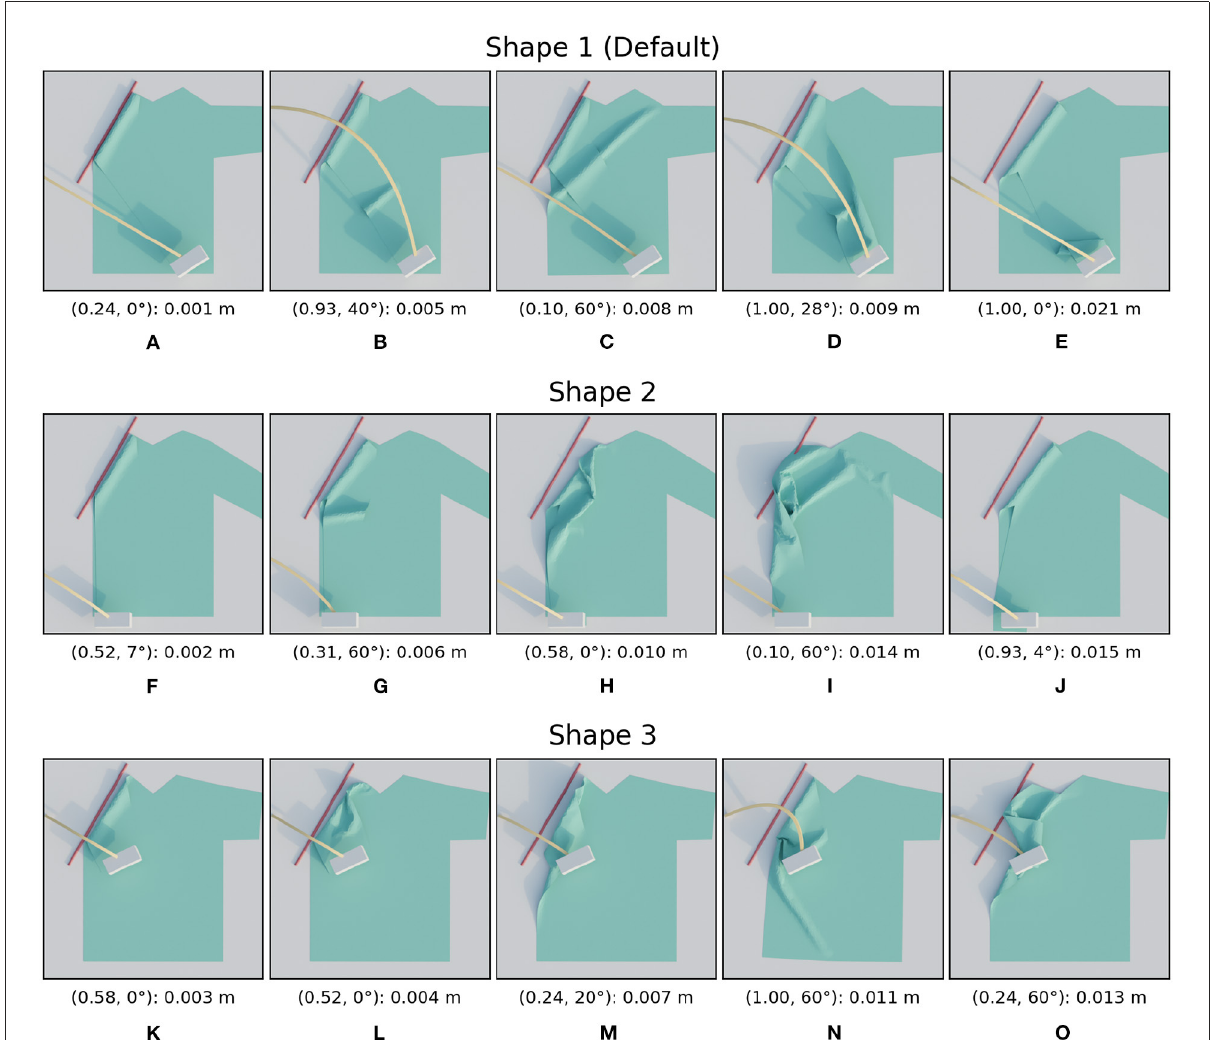
FIGURE8 Images of simulated results for the shape variations. For each row, the images are ordered from best (left) to worst (right) result. The annotation below each image is in the following format: (height ratio, tilt angle): mean distance. The first row (A–E) shows the images for shape 1, the second row (F–J) for shape 2, and the third (K–O) for shape